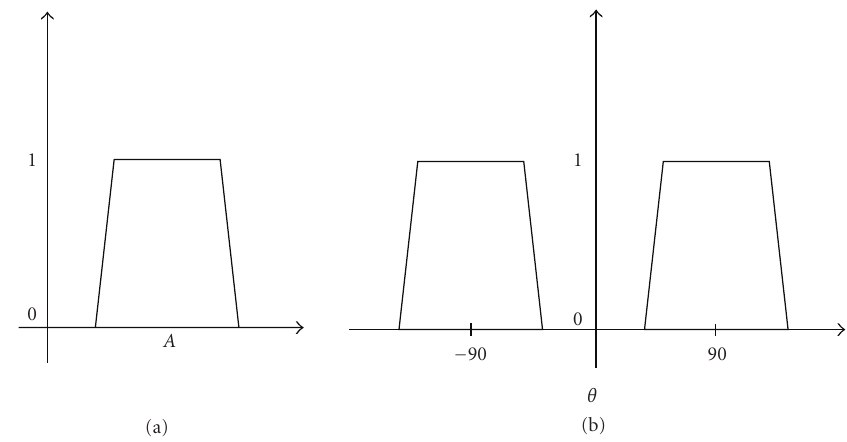
Figure 7: Form of membership functions for pipe connection size and location.